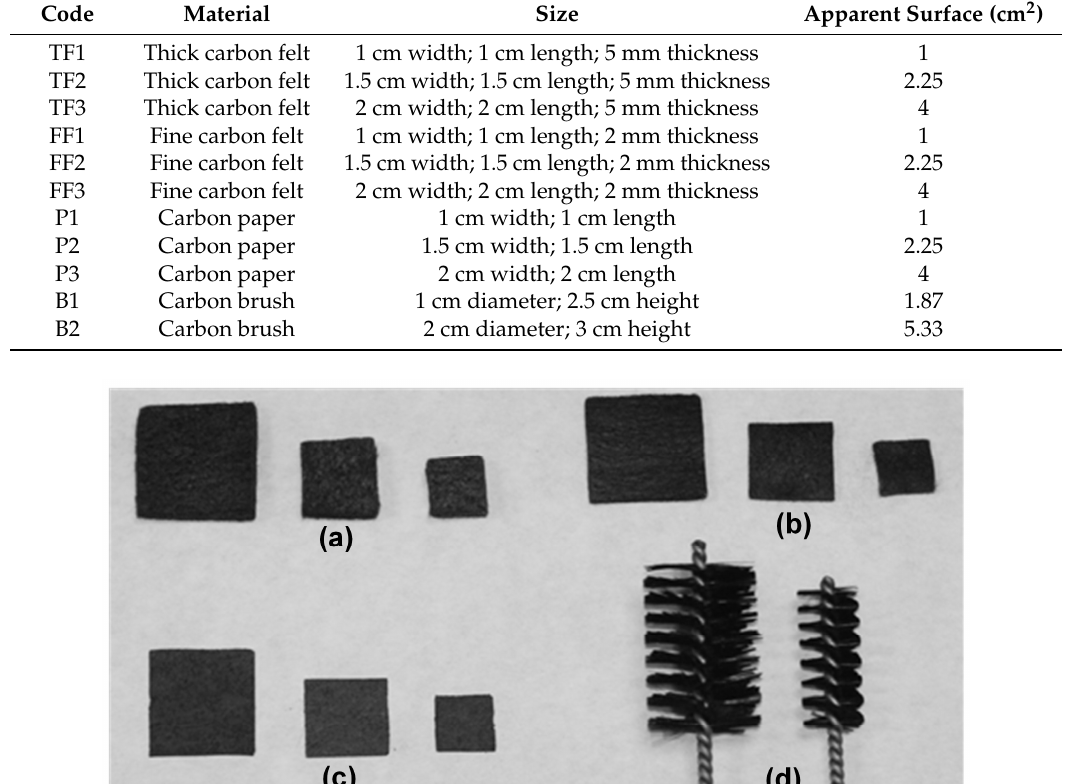
Figure 1. 0.5 cm-thick carbon felt ( a ); 0.25 cm-thick carbon felt ( b ); carbon paper ( c ); and brush ( d ) electrodes.